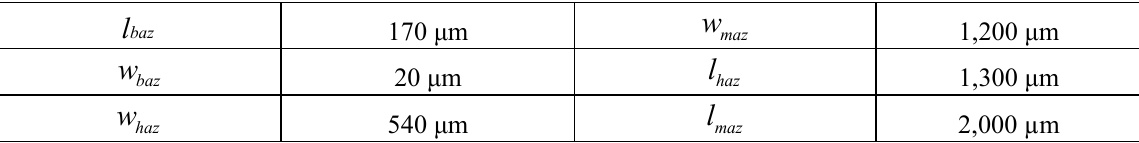
Table 5. Dimensions of Z-axis accelerometer.